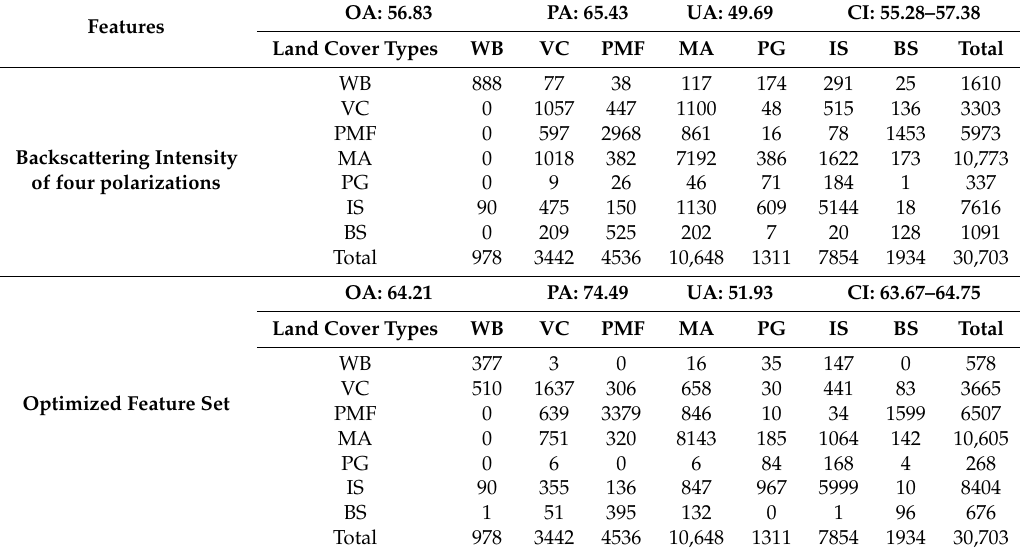
Table 8. The confusion matrix from RF in Guyuan.